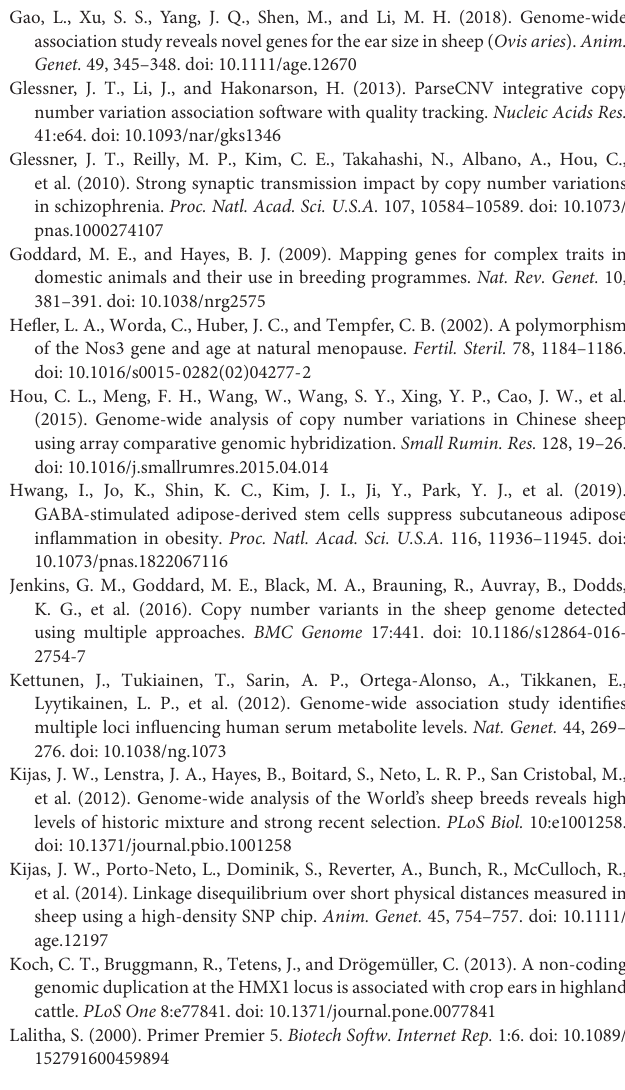
Supplementary Figure 1 | Normalized ratio (NR) obtained by qPCR for the nine randomly selected CNVRs. The y-axis shows the NR values obtained by qPCR, and the x-axis shows the sample names in the different CNV regions. Samples with NRs of approximately two have the diploid normal copy numbers, samples with NRs of approximately have one loss-of-copy allele and samples with NRs of more than two have gain of copy number. Supplementary Figure 2 | Neighbor-joining clustering based on the Manhattan distances matrix computed from CNVs for each population. Supplementary Figure 3 | (A) ADMIXTURE analysis for K values 2 to 7 for the 67 domestic sheep populations. (B) Principal component analysis (PCA) of the domestic sheep populations. The circles of yellow, blue, green represent Eastern-Central Asian, Western Asian and African populations, respectively. Supplementary Figure 4 | Principal component analysis (PCA) of the domestic sheep populations for four geographic groups. Codes for the populations are detailed in supplementary table 1. Supplementary Figure 5 | Manhattan plots of GWAS of (A) polyceraty of Sishui Fur sheep; (B) tail weight of Han sheep; (C) supernumerary nipples of Wadi sheep; and (D) Ear size of Duolang sheep. The threshold of adjusted P < 0.05 is indicated by a dotted